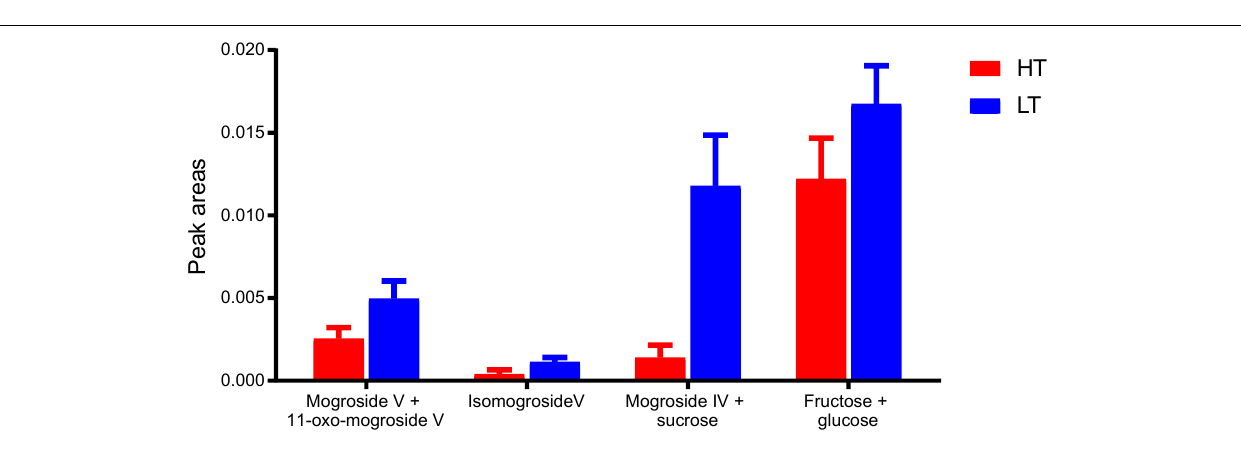
fell within the Hotelling T2 (0.95) ellipse, where the model fit parameters were 0.699 of R 2 X , 0.974 of R 2 Y , and 0.929 of Q 2